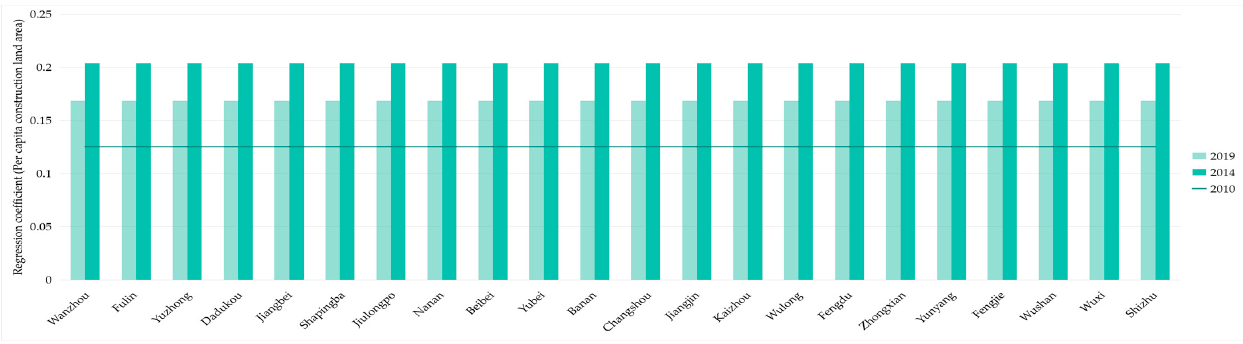
Figure 16. Spatial distribution of regression coefficient of L-UDI in year 2010, 2014, and 2019 (presented in subfigure a – c , respectively). Sources: Calculation results of the GWR model from the land-use dimension.